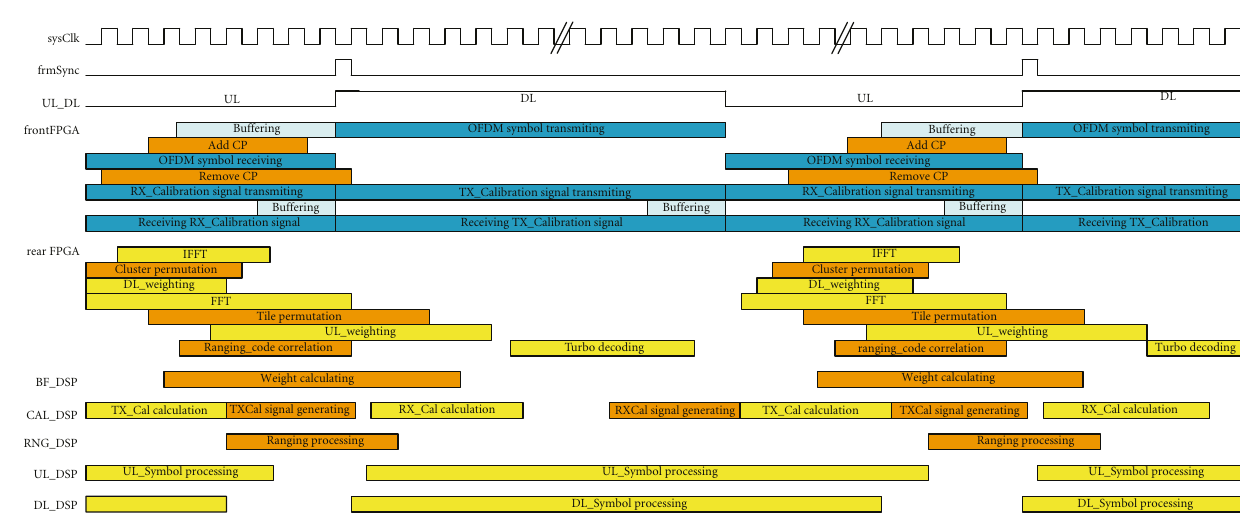
Figure 7: Timing diagram for baseband signal